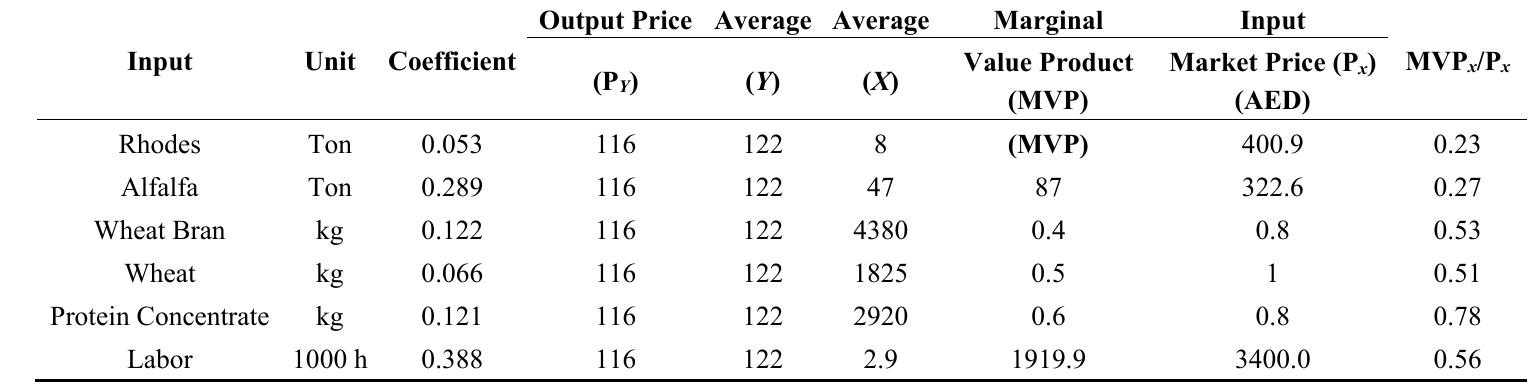
Table 2. Allocative efficiency of the significant inputs used in the production of sheep. MVP, marginal value product; AED, Arab Emirates